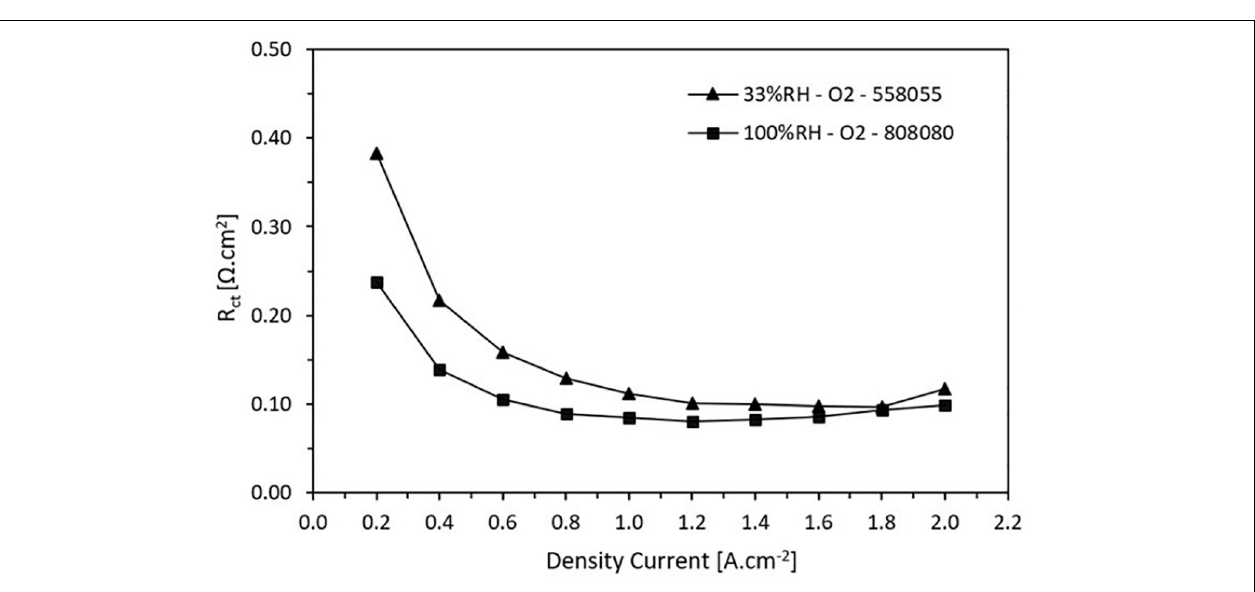
Frontiers in Energy Research |